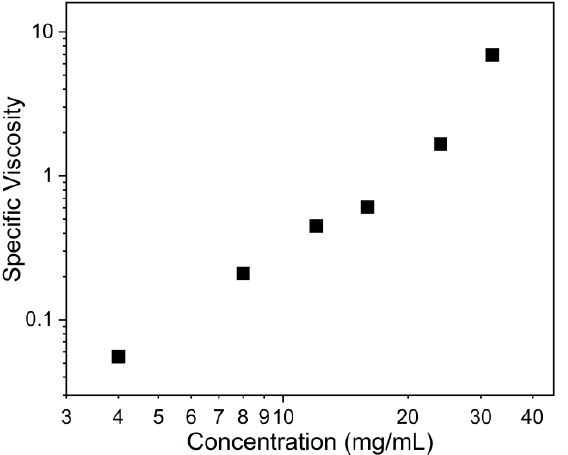
Figure 3. Special viscosities of PPMU at 298 K in CHCl 3 at different concentrations.